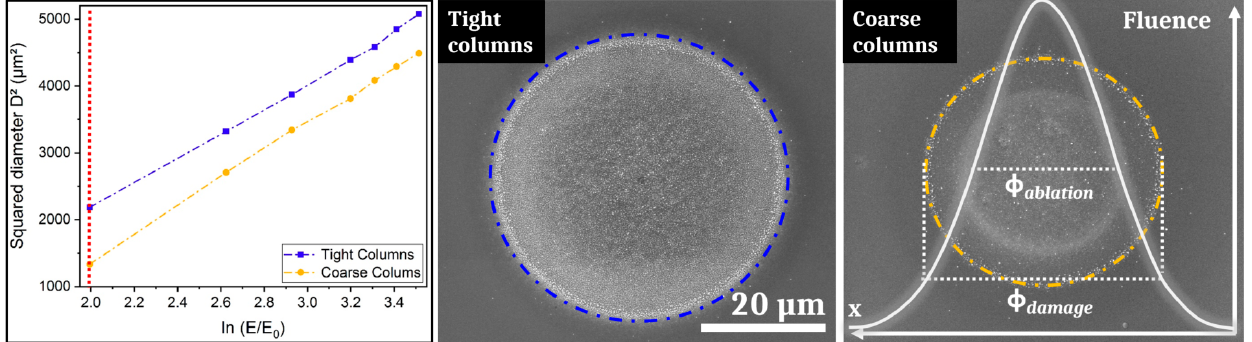
Figure 1. Evolution of the squared diameter versus the neperian logarithm of the energy of irradiation for a single pulse irradiation. The scanning electron microscope (SEM) images show the impact aspect for both samples for the lowest irradiation fluence (F 1p = 0.25 J/cm 2 ) corresponding to the value displayed by the red line: ln(E/E 0 ) = 2 (with E 0 = 1 µJ).